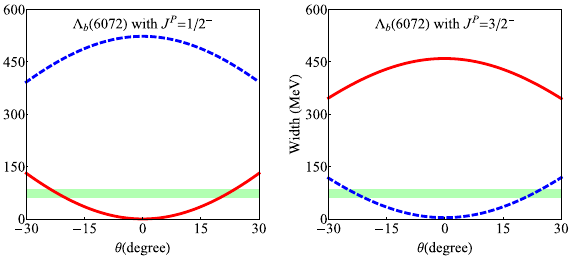
Fig. 3 The total decay widths versus the mixing angle θ . The red solid and blue dashed lines correspond to the | 1 P J P (cid:6) 1 and | 1 P J P (cid:6) 2 states, respectively, where the J P equals to 1 / 2 − or 3 / 2 − . The green bands are the experimental total decay widths